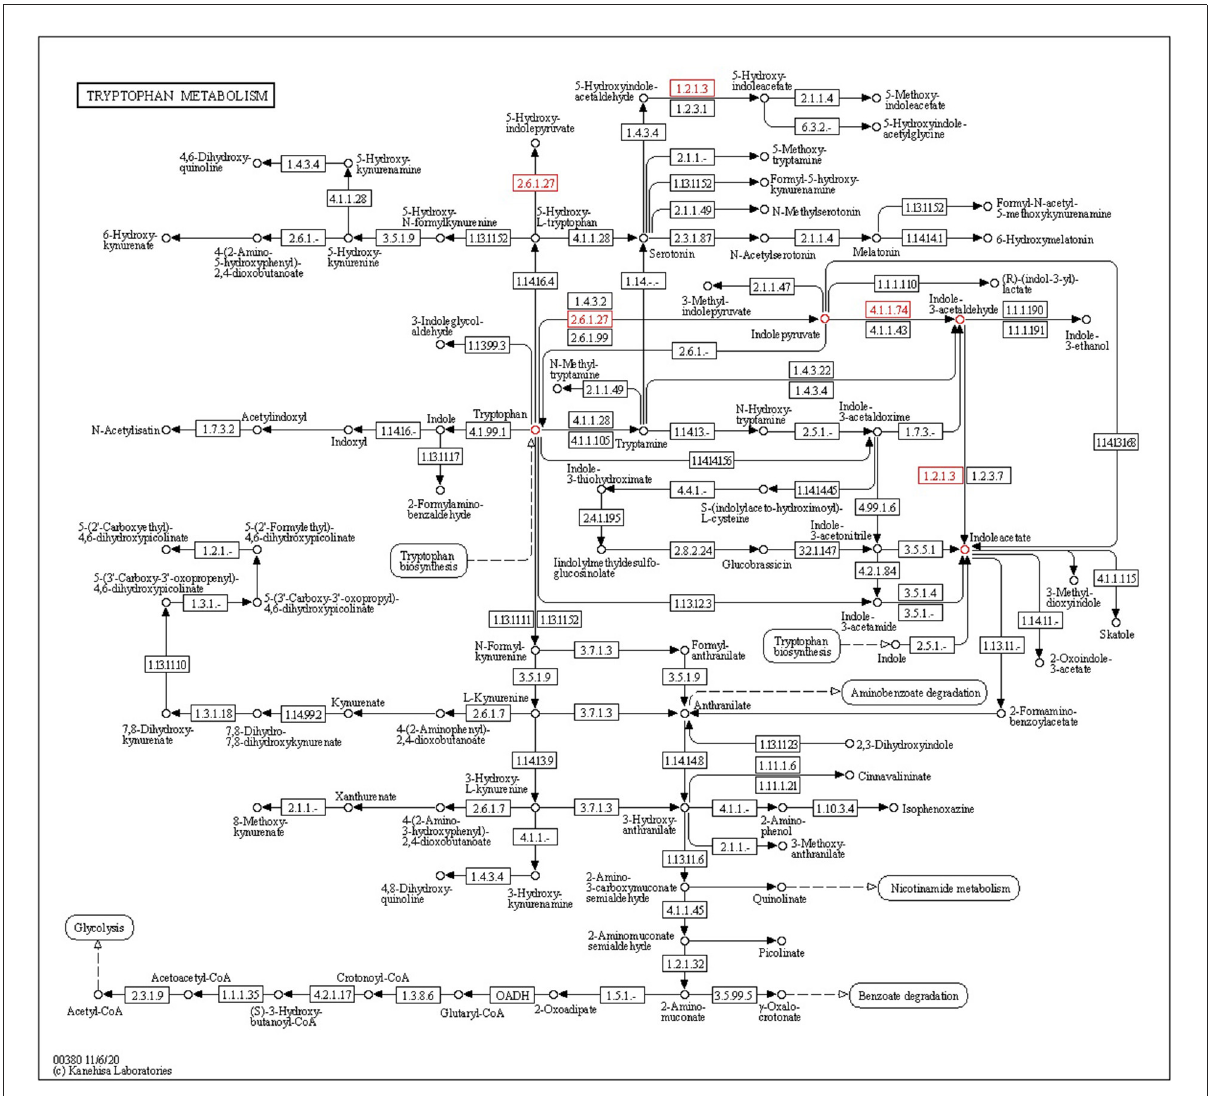
FIGURE8 KEGG pathway gene mapping of the strain CPHN2 for indole-3-acetic acid (IAA) synthesis.